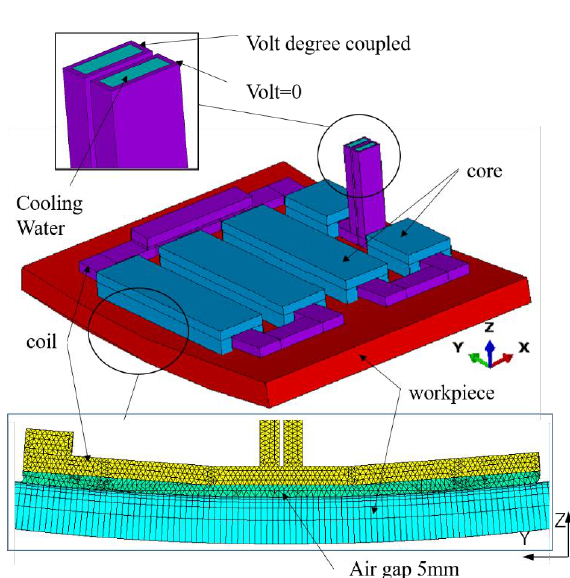
Figure 3. Finite element method (FEM) model for the electromagnetic calculation and the mesh of the air gap.